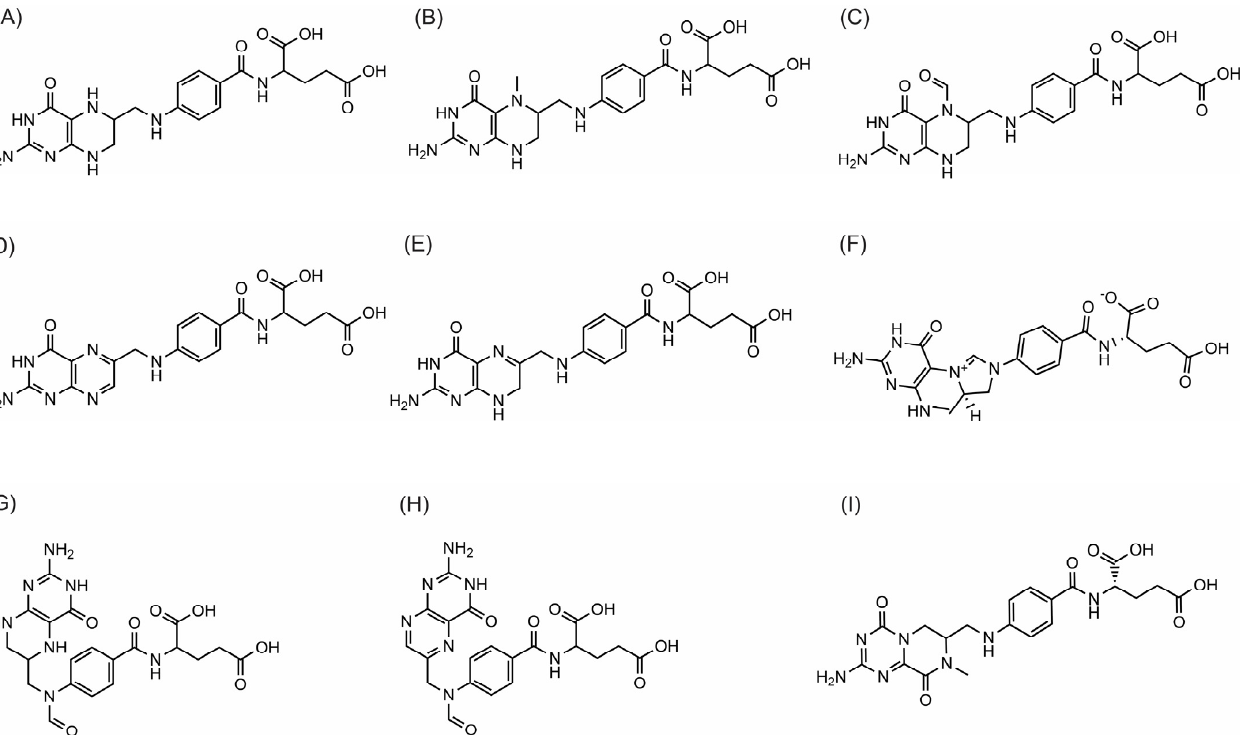
Figure 1. Chemical structures of folate vitamers in soybean: ( A ) H 4 folate (THF); ( B ) 5-CH 3 -H 4 folate (5MTHF); ( C ) 5-CHO-H 4 folate (5FTHF); ( D ) PteGlu (FA); ( E ) H 2 folate (DHF); ( F ) 5,10-CH=H 4 folate (5,10-MTHF); ( G ) 10-CHO-H 4 folate; ( H ) 10-CHO-PteGlu (10FFA); ( I ) MeFox.